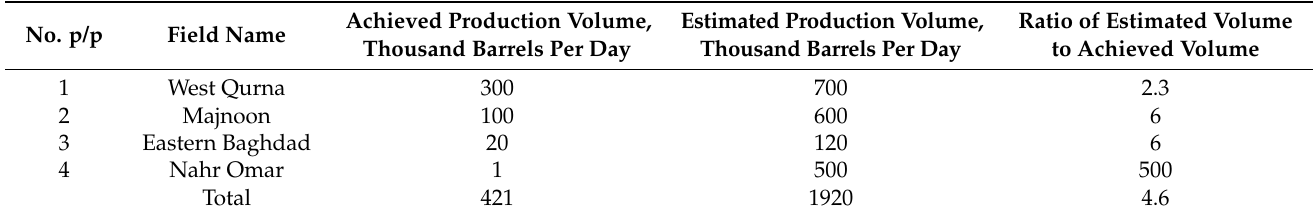
Table 4. Achieved and estimated volumes of hydrocarbon production.